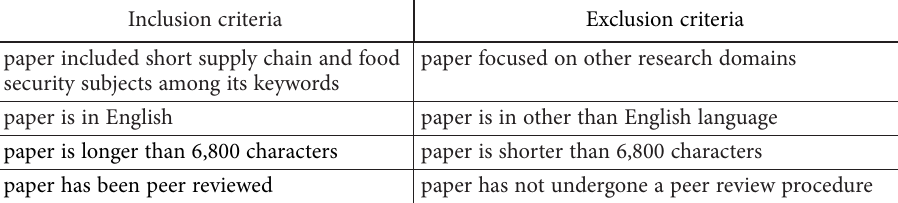
Table 1. Inclusion and exclusion criteria for